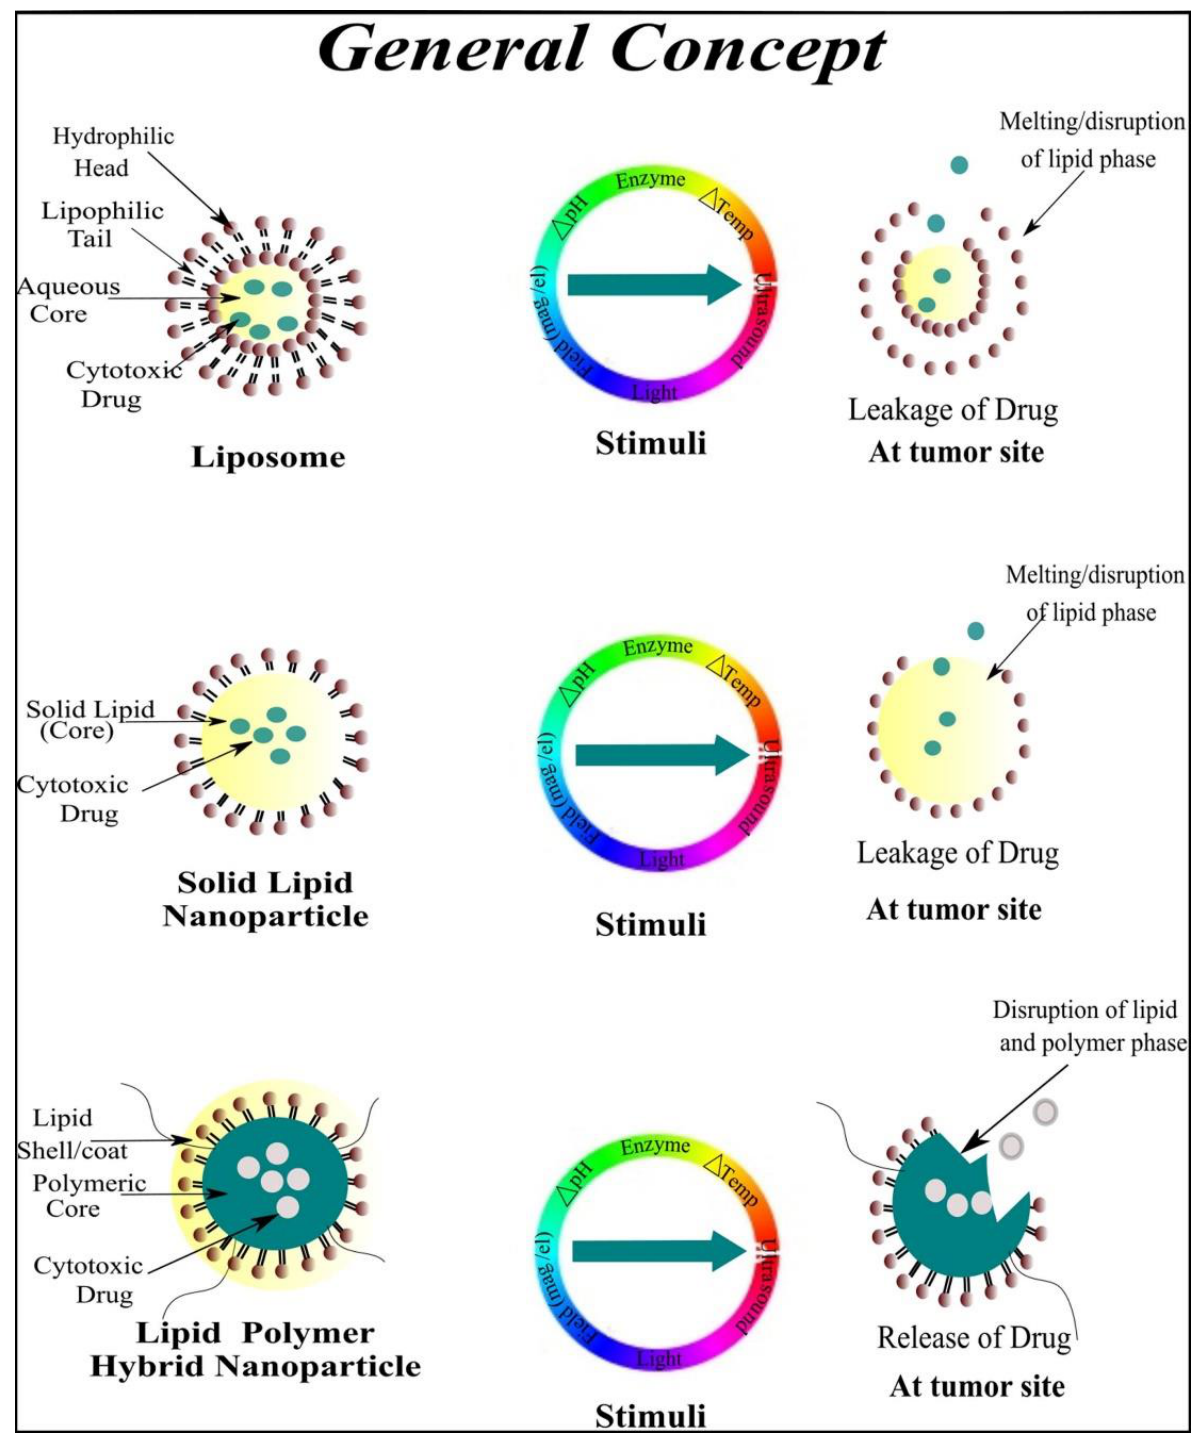
Figure 4. General Concept Regarding Stimuli-Responsive Lipid-Based Drug Delivery Systems Used for Cancer Chemotherapy .